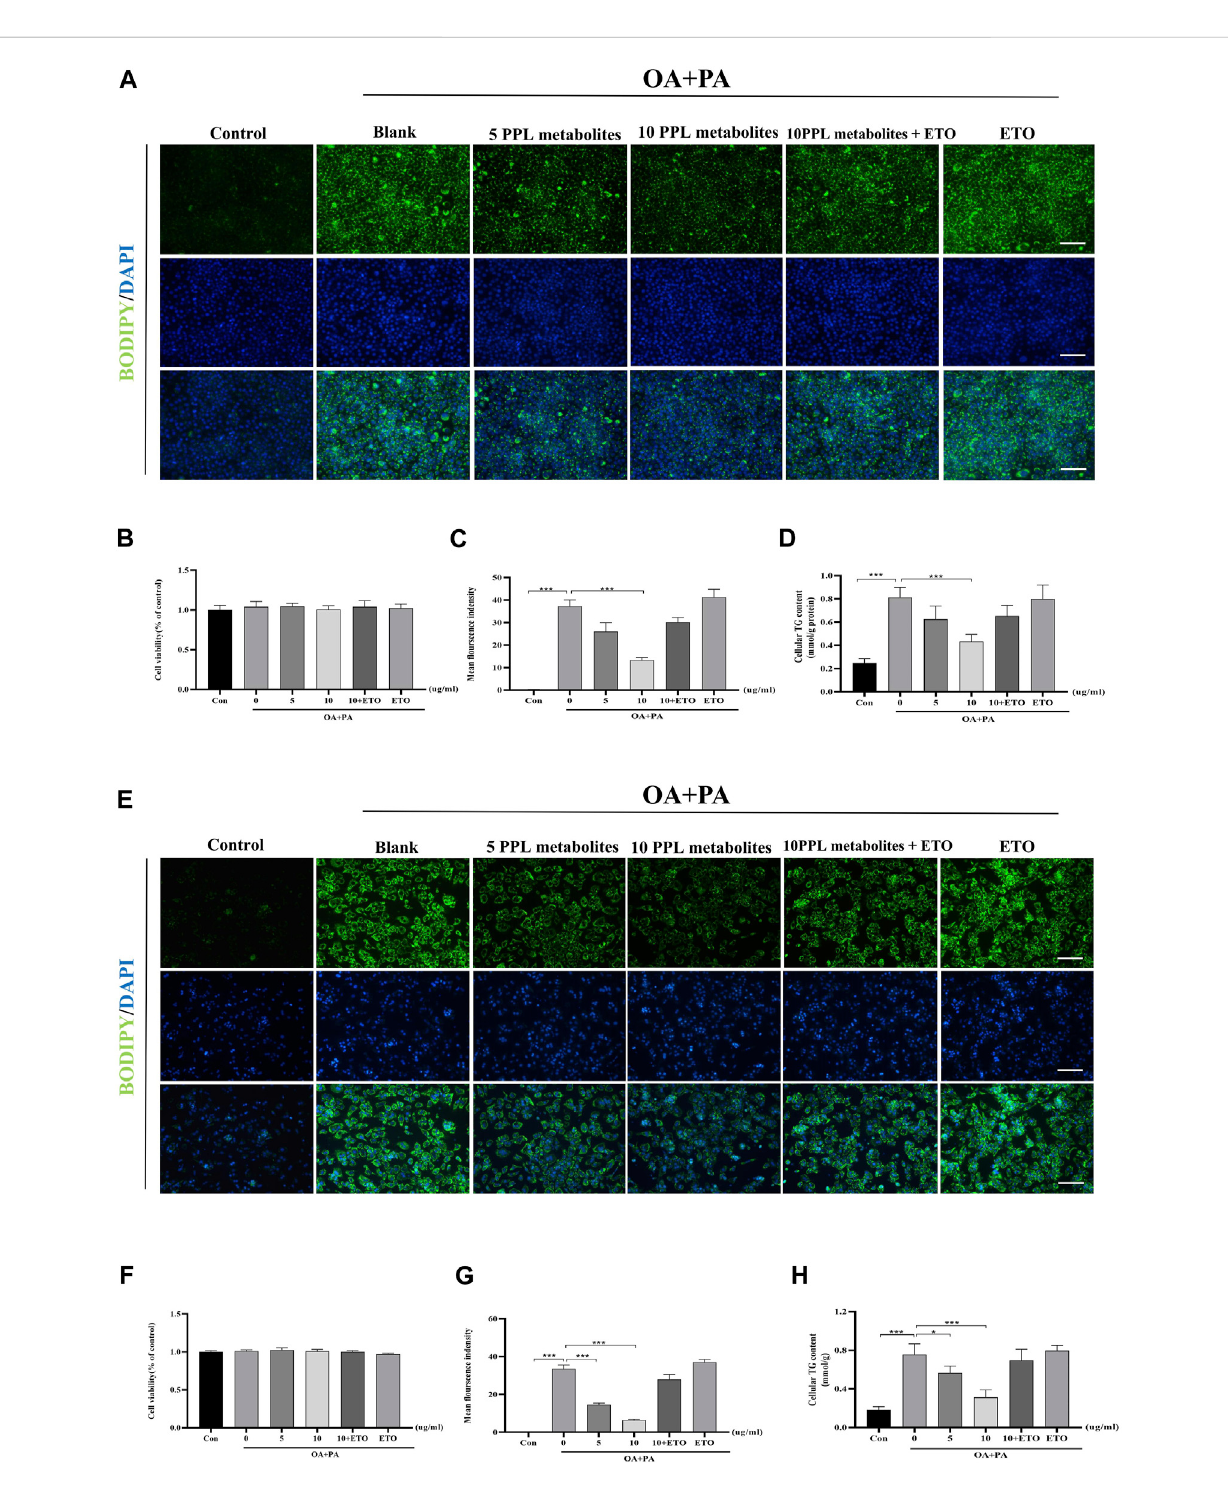
FIGURE 7 ETO blocked the lipid-lowering effect of PPL metabolites in PA/OA-treated hepatocytes. (A) BODIPY 493/503 staining of PA/OA-induced lipid accumulation in AML12 cells after treating with PPL metabolites and ETO for 24 h. (B) Cell viability was detected by CCK8 assay after AML12 cells incubated with PPL metabolites and ETO for 24 h (n = 9 per group). (C) BODIPY positively stained area (n = 3 per group). (D) Cellular TG levels were detected after AML12 cells incubatedwith PPLmetabolitesand ETO for 24 h(n = 4per group). (E) BODIPY 493/503 stainingof PA/OA-inducedlipid accumulation inmiceprimaryhepatocytesaftertreatedwithPPLmetabolitesandETOfor24 h. (F) CellviabilitywasdetectedbyCCK8aftermiceprimary hepatocytesincubatedwithPPLmetabolitesandETOfor24 h(n=9pergroup). (G) BODIPYpositivelystainedarea(n=4pergroup). (H) CellularTGlevels were detected after mice primary hepatocytes incubated with PPL metabolites and ETO for 24 h (n = 4 per group). Magni fi cation: ×200, scale bar: 100 μ m. Data were expressed as the mean ± SEM. Differences among groups were compared by one-way ANOVA. * p < 0.05, ** p < 0.01, *** p <